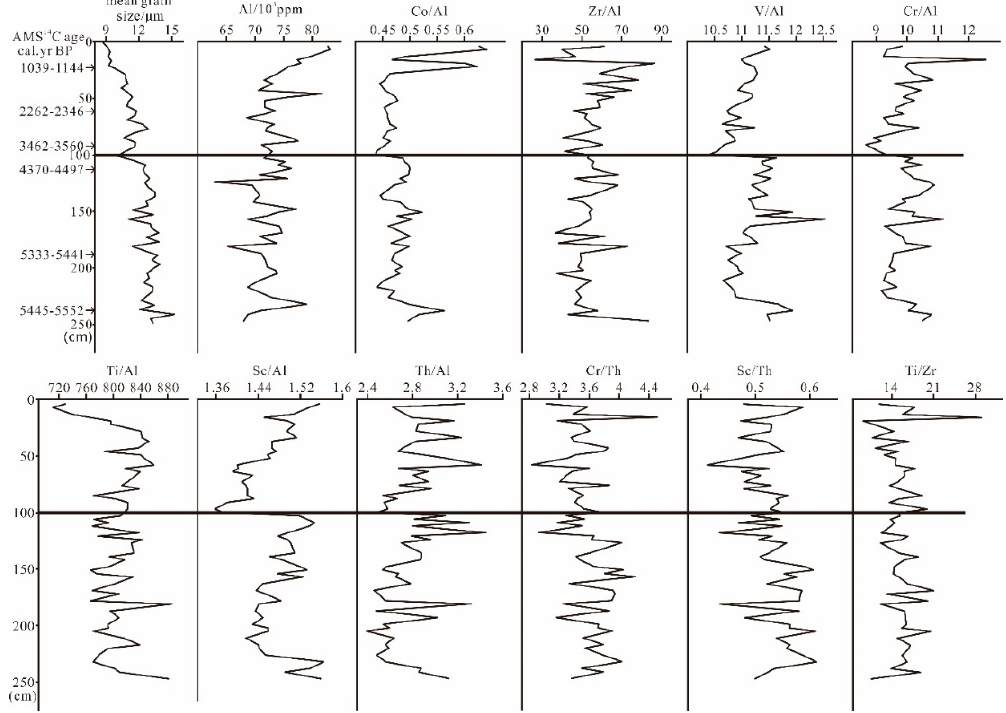
Figure 3. Mean grain size and geochemical characteristics of the residual sediments (<45 µm) in core F15. AMS 14 C age and granularity information are cited from [45].